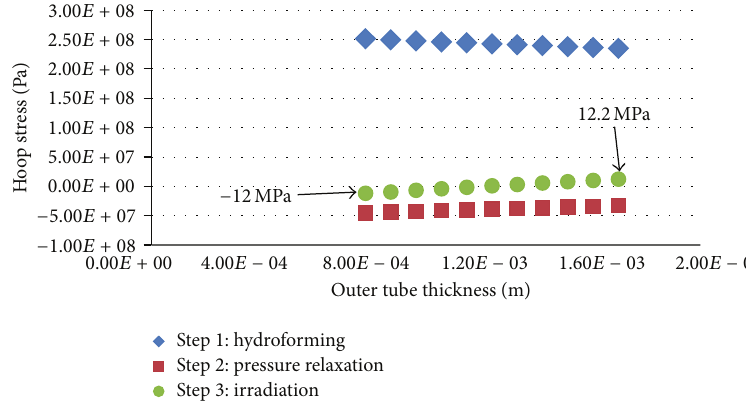
Figure 13: Hoop stress distribution in the outer tube through various modeling steps at 𝜃 = 270 ∘